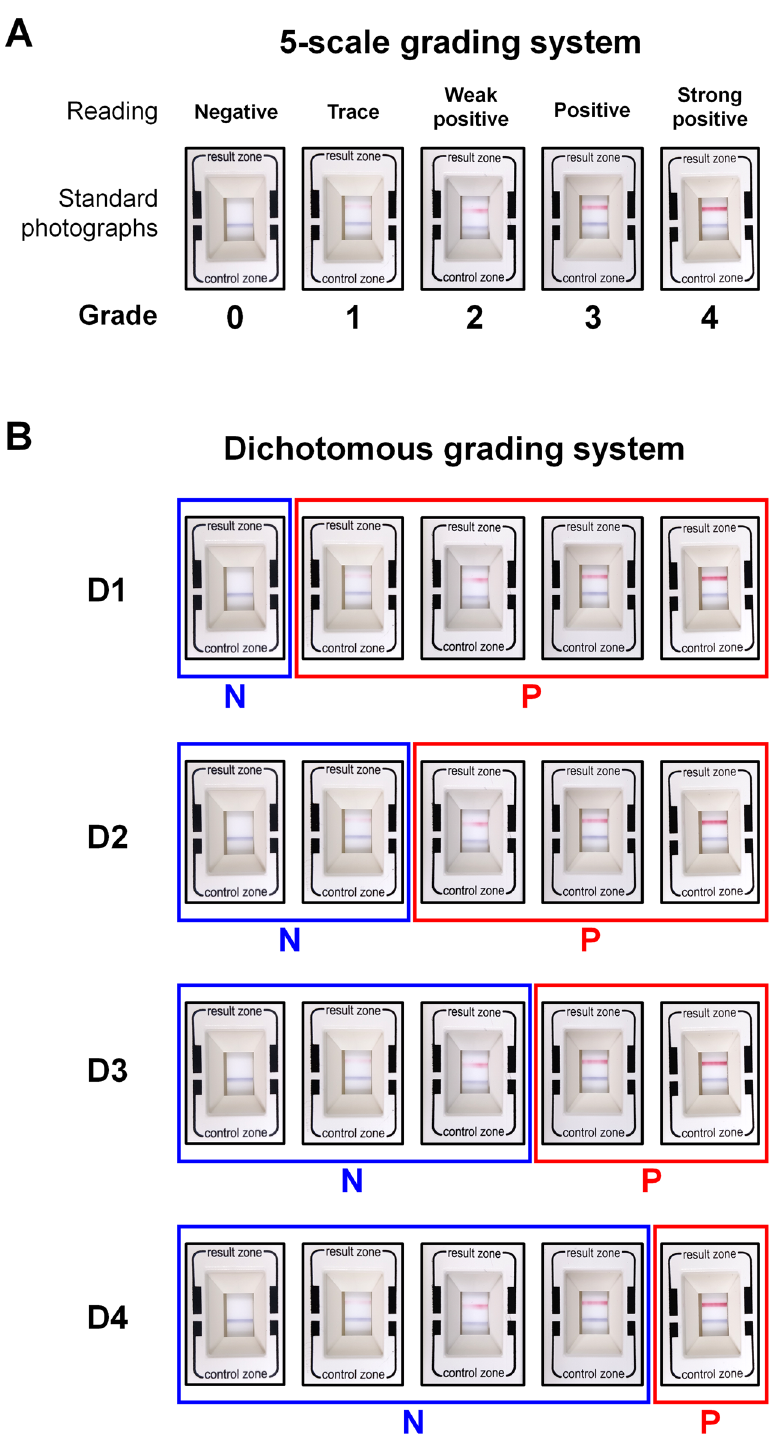
Figure 2. Standard photographs for tear matrix metalloproteinase (MMP)-9 expression, graded using a 5-scale grading and a dichotomous grading system (D1 to D4). ( A ) The 5-point scale ranges from 0 to 4 and is represented by the color density of the red line in the readout window of the point-of-care MMP-9 immunoassay. ( B ) The dichotomous grading system defines positive results as grades 1, 2, 3, and 4 of the 5-point scale (D1, D2, D3, and D4,